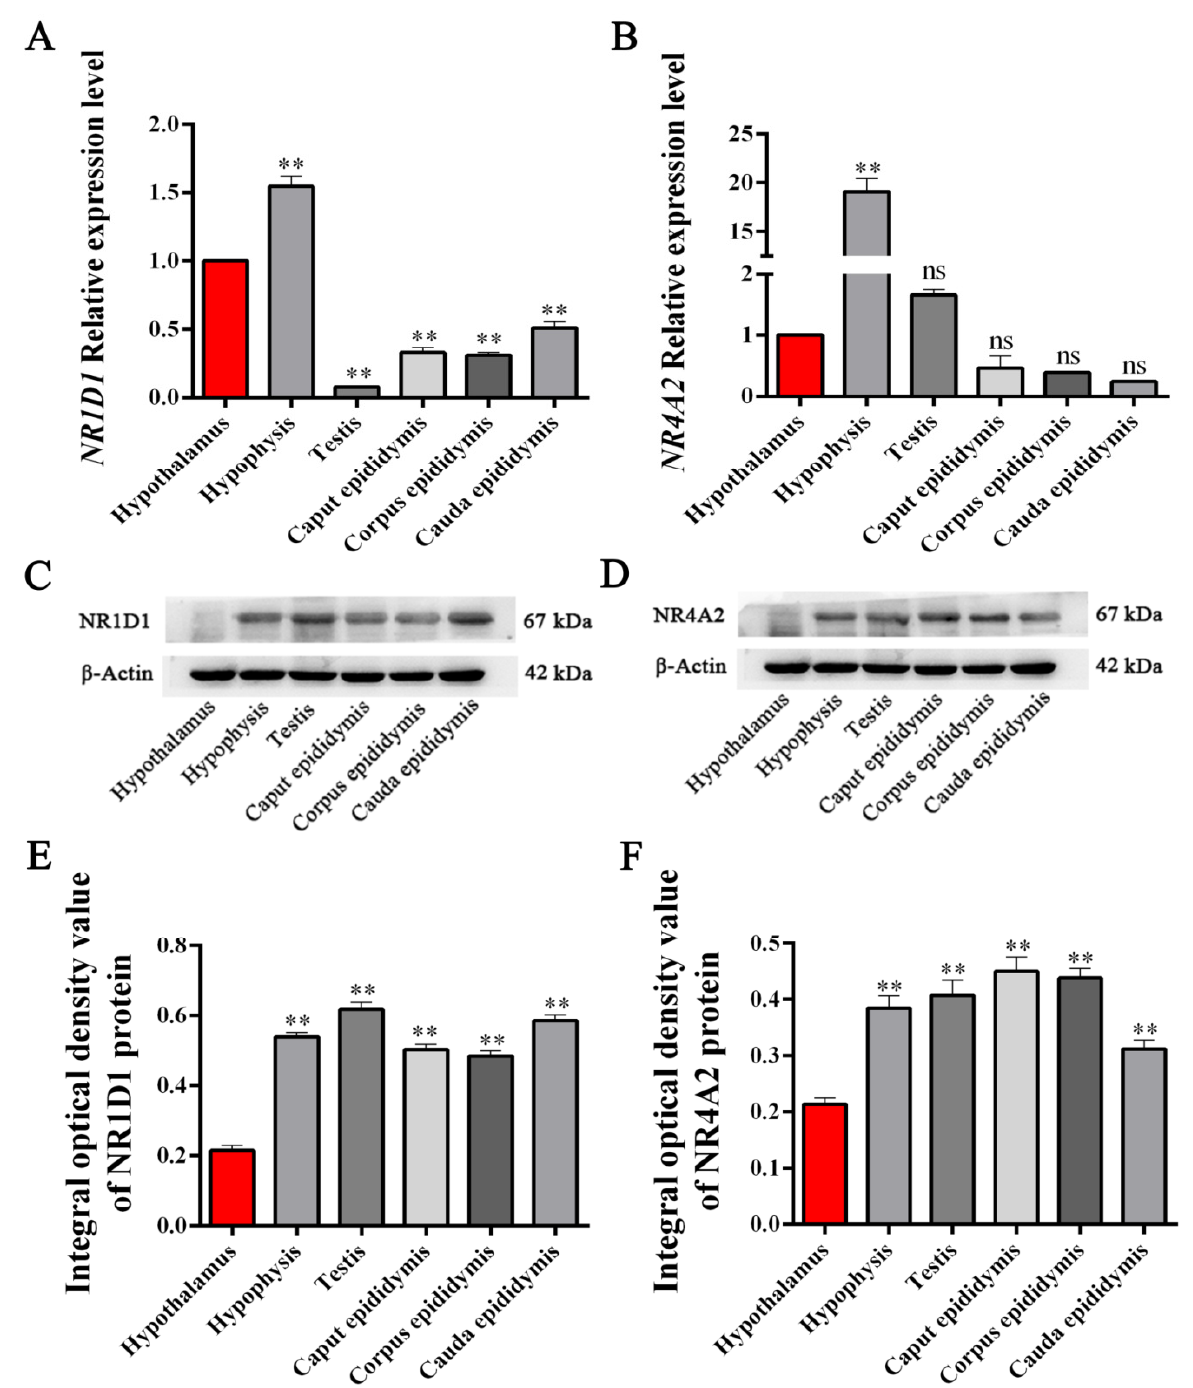
Figure 4. The expression levels of NR1D1 and NR4A2 mRNA and proteins in adult yak (4 years old) HPG tissues. ( A , B ), The expression of NR1D1 and NR4A2 mRNA, respectively, in yak HPG tissues, measured using qPCR. ( C , D ), The expression of NR1D1 and NR4A2 protein, respectively, in yak HPG tissues, measured using Western blot. ( E , F ), The IOD values of NR1D1 and NR4A2 proteins in yak HPG tissues, respectively. The expression levels of NR1D1 and NR4A2 mRNA and protein in the hypothalamus were used as the controls. The expression of β -actin was used as an endogenous control. *, represent significant difference vs. control ( p < 0.05 ), **, represent extremely significant difference vs. control ( p < 0.01 ).